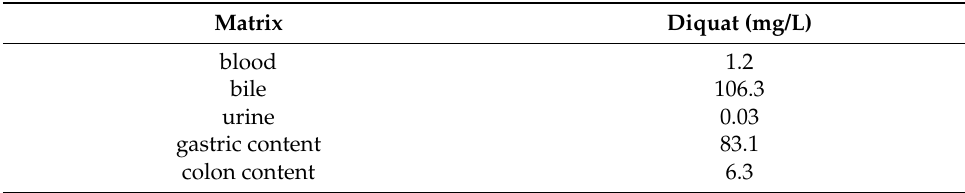
Table 1. Diquat concentrations evidenced by GC/MS analyses performed on post-mortem blood, urine, bile, and gastric and colon